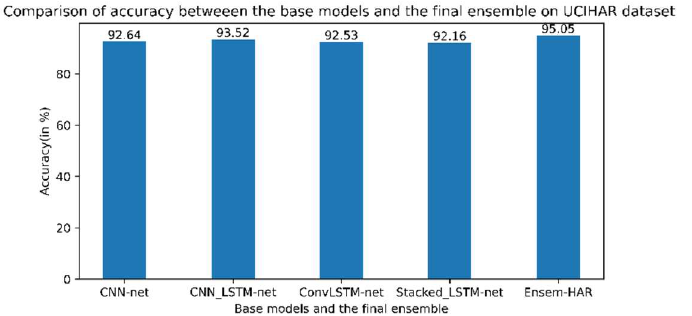
Figure 19. Accuracy (in %) comparison between four base models and Ensem-HAR model on the UCI-HAR dataset.